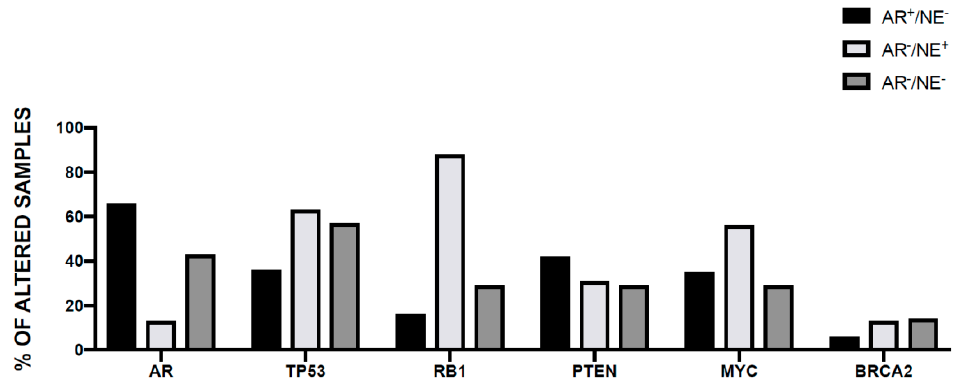
Figure 4. Molecular features (recurrent genomic alterations) or prostate cancer (CRPC) subdivided into three subgroups according to the expression and signaling activity of AR into AR + and AR - and to the presence or not of neuroendocrine features into NE + and NE - . The data are reported in Bluemn et al. [215].